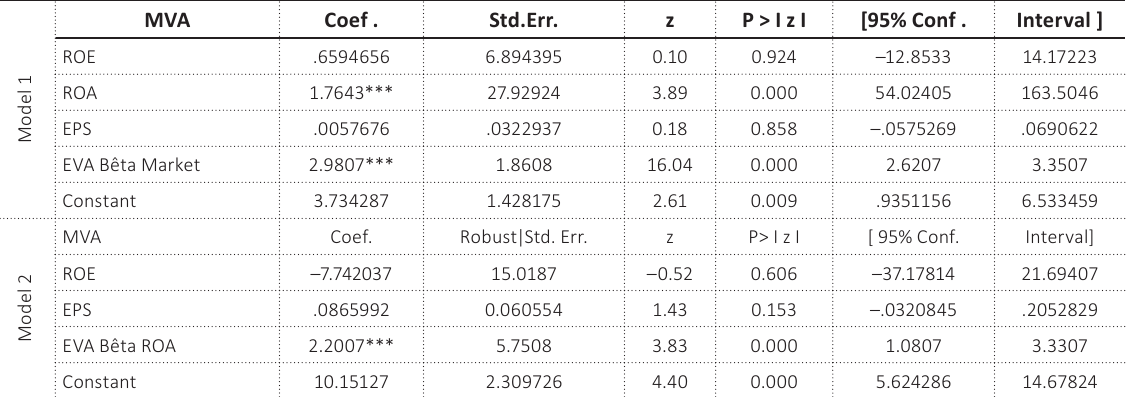
Table 11. Corrected regression for heteroscedasticity and autocorrelation